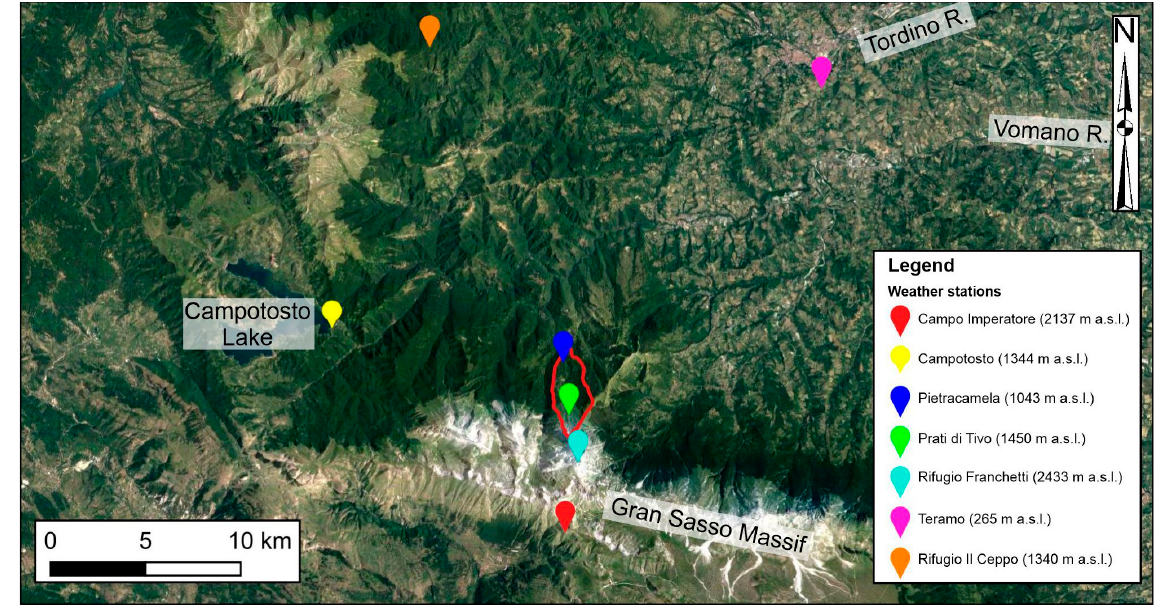
Figure 4. Spatial distribution of the weather gauges used in the present study. The red line indicates the location of the study area.